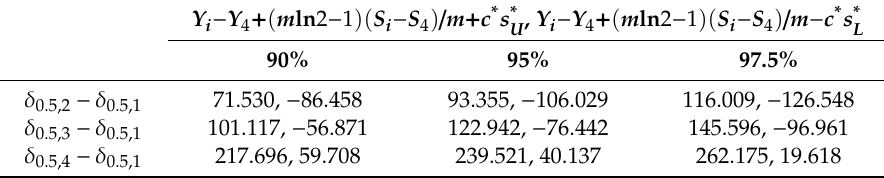
Table 4. The 90%, 95%, and 97.5% upper bounds (the number before comma) and lower bounds (the number after comma) for three categories compared with the control category (Category 1).